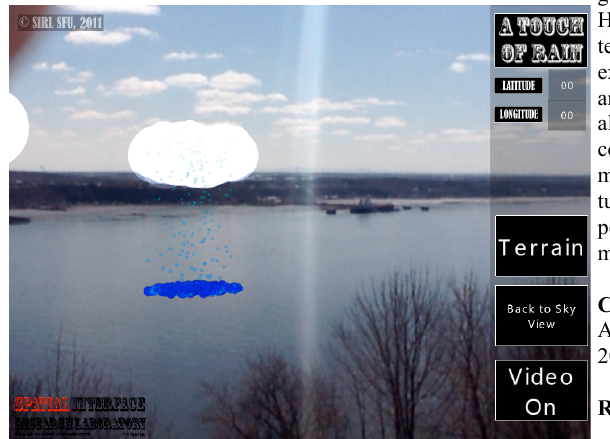
Figure 9. A live screen capture from An Augmented Touch of Rain . The user can look around them at the real world through the tablet device and see the virtual clouds that they created. (Note: this view is more clearly an ‘augmented reality’